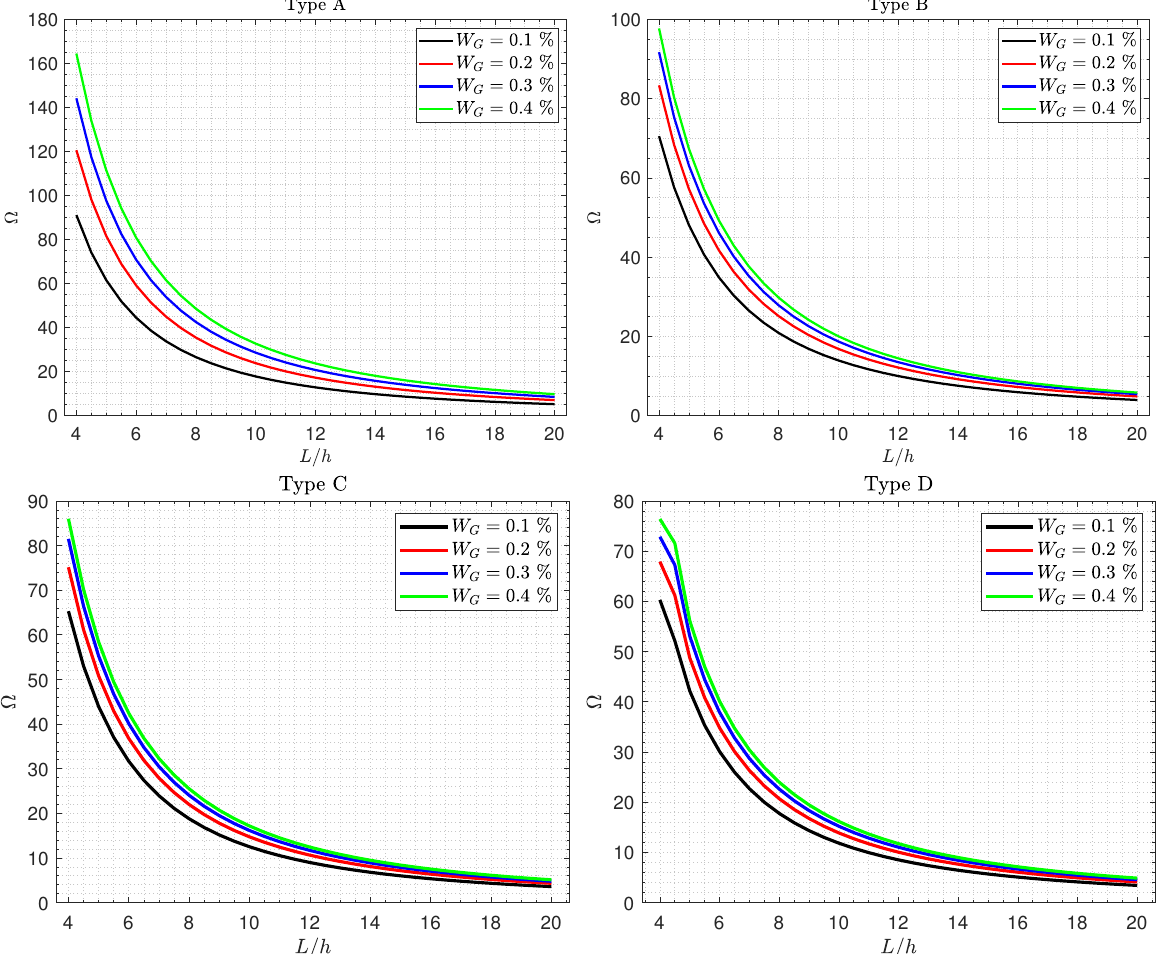
Figure 5. Effects of the graphene weight fraction W G on the frequency of different types of the nanocomposite piezoelectromagnetic